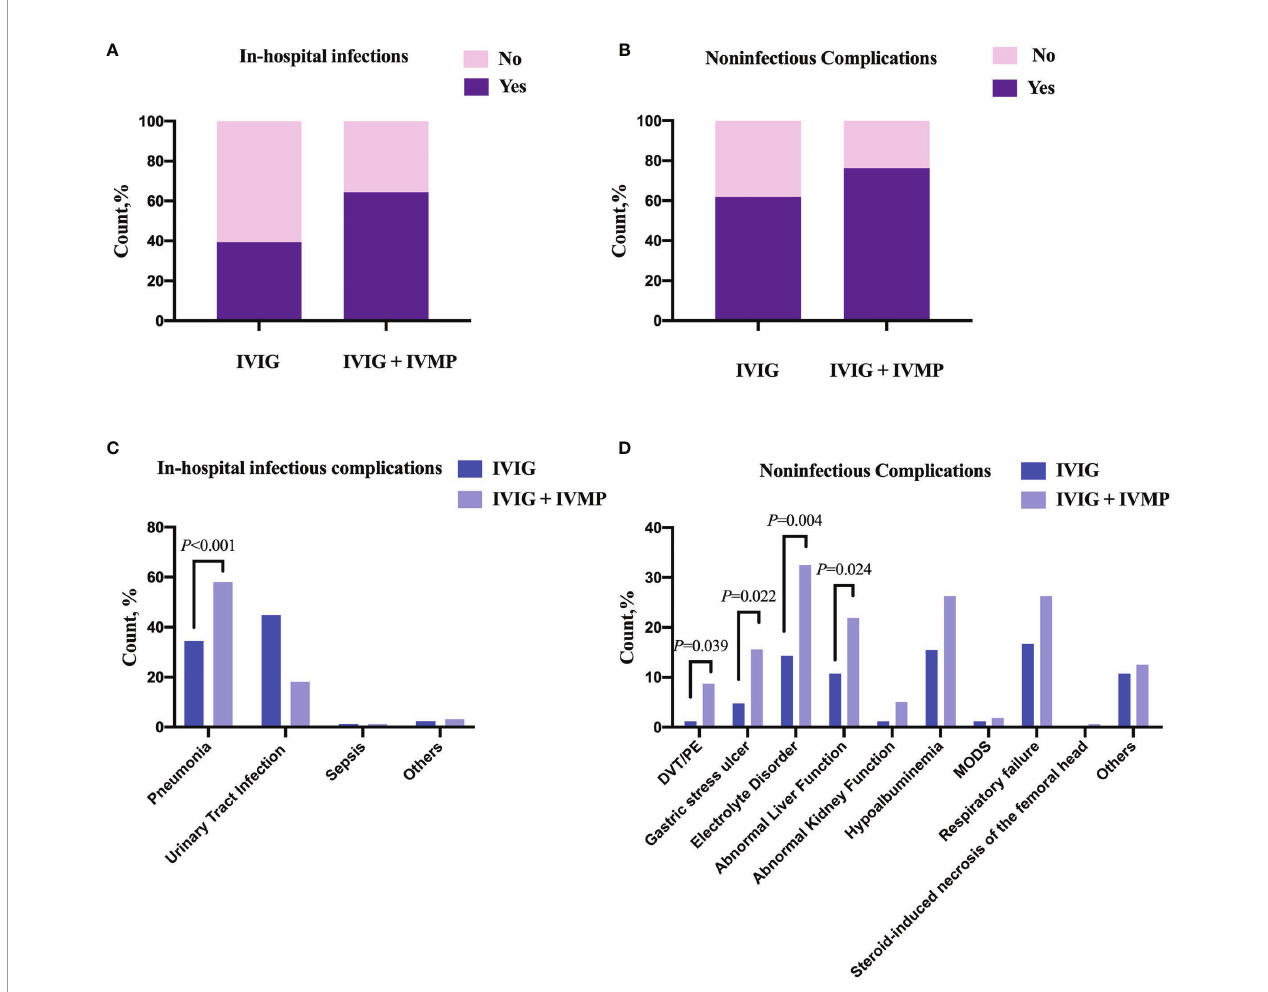
FIGURE 1 | Comparison of the occurrence of complications between anti-NMDAR encephalitis patients with and without large-dose steroids treatment. (A, B) The occurrence of infections or noninfectious complications in both groups. Patients in the IVIG + IVMP group had a higher occurrence of infections or noninfectious complications than those in the IVIG group. (C, D) Types of complications in both groups. The frequency of pneumonia was highest in the infections followed by the urinary tract infections and sepsis. The proportions of DVT/PE, gastric stress ulcers, electrolyte disorders and abnormal liver function were signi fi cantly higher in the IVIG + IVMP group (8.75% vs 1.19%, P = 0.039; 15.63% vs 4.76%, P = 0.022; 32.50% vs 14.29%, P =0.004; 21.88% vs 10.71%, P = 0.024, respectively). DVT/PE, deep venous thrombosis/pulmonary embolism; MODS, multiple organ dysfunction syndrome. Differences between variables were compared using c 2 test, c 2 analysis with continuity correction or Fisher ’ s exact test, as